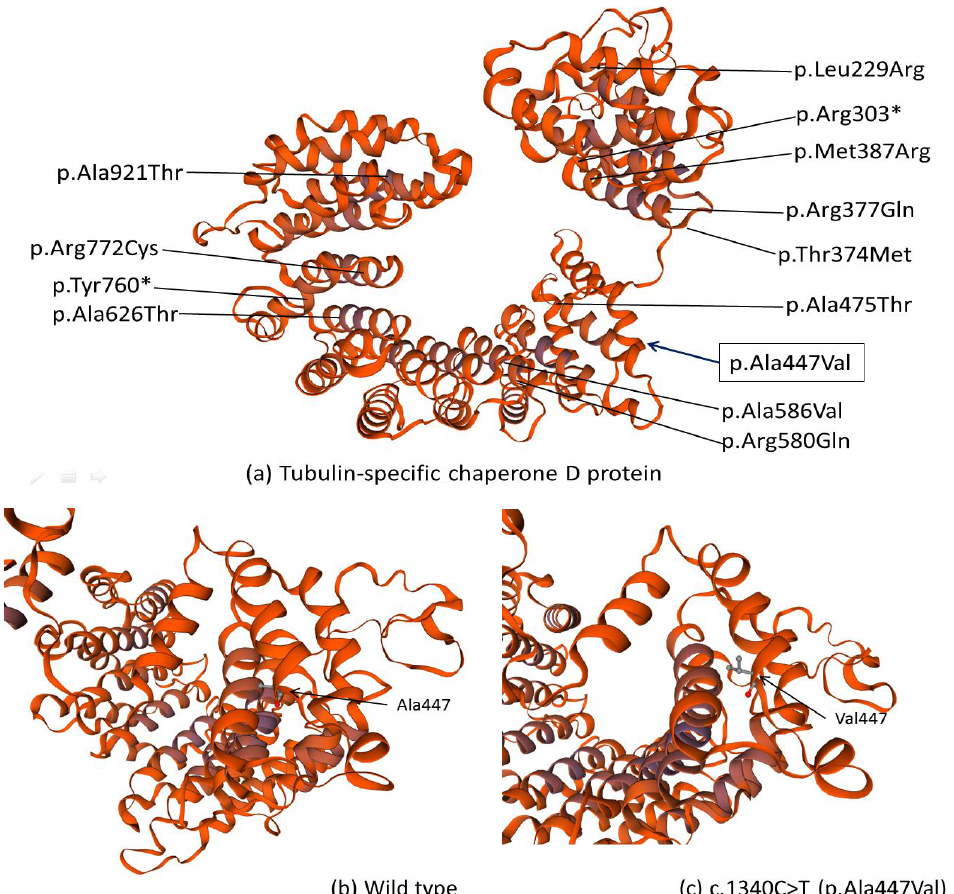
Figure 4. Homology-Modeled Structures of TBCD protein (UniProtKB AC: Q9BTW9) based on Swiss-model template (ID 1qgr.1.A, covering TBCD amino residues 194-931). ( a ) The secondary and tertiary structure prediction of TBCD ; the locations of missense mutations previously published in past literatures are labeled. Variants that fall outside of this coverage are not shown. The location of our reported variant Ala447 is boxed. ( b ) shows the zoomed-in view of ( a ) at a different angle. The location of Ala447 in α -helix, the orientation and spacing of adjacent helices are labeled in ( b ) compared to its mutant form Val447 ( c ). The star sign (*) denotes termination of the amino acid sequence, resulting in a truncated protein.